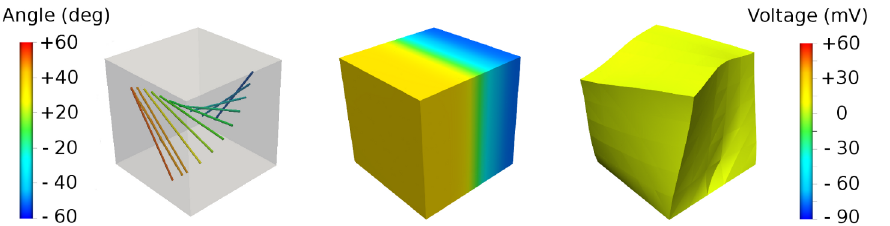
Figure 4. Cardiac electromechanics in a ventricular wedge: left, fibre orientation relative to Z axis; middle and right, simulation of electrical propagation and deformation (middle: 1 ms after stimulus on left face ( X ~ 0 ); right: 35 ms after stimulus). See also Video